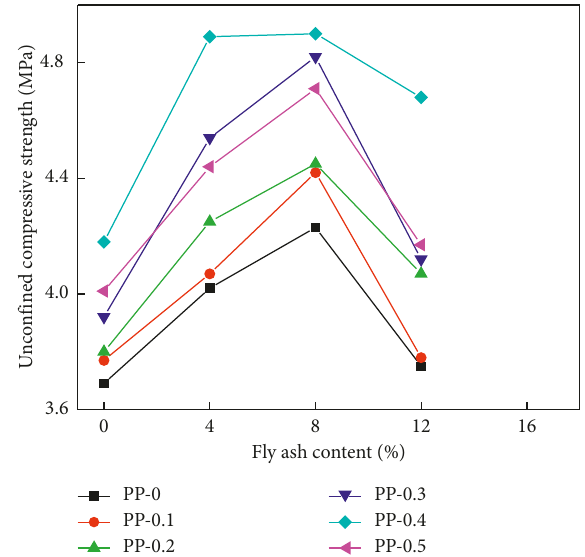
Figure 4: Relationship between unconfined compressive strength and fly ash